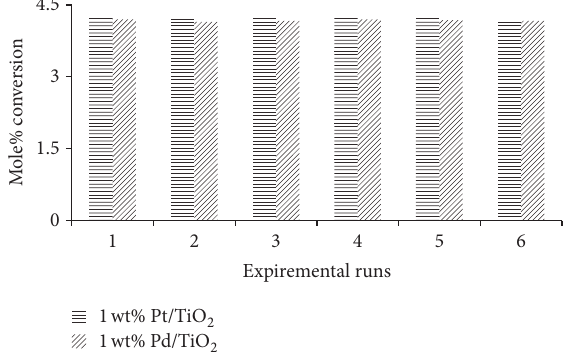
Figure 8: Life span of the catalysts for photooxidation of toluene. Reaction conditions : toluene: 20 mL, cat: 100 mg, temp: 333 K, irradi- ance: 3hrs, flow: 40mL/min, pO 2 : 760 torr, and stirring: 850